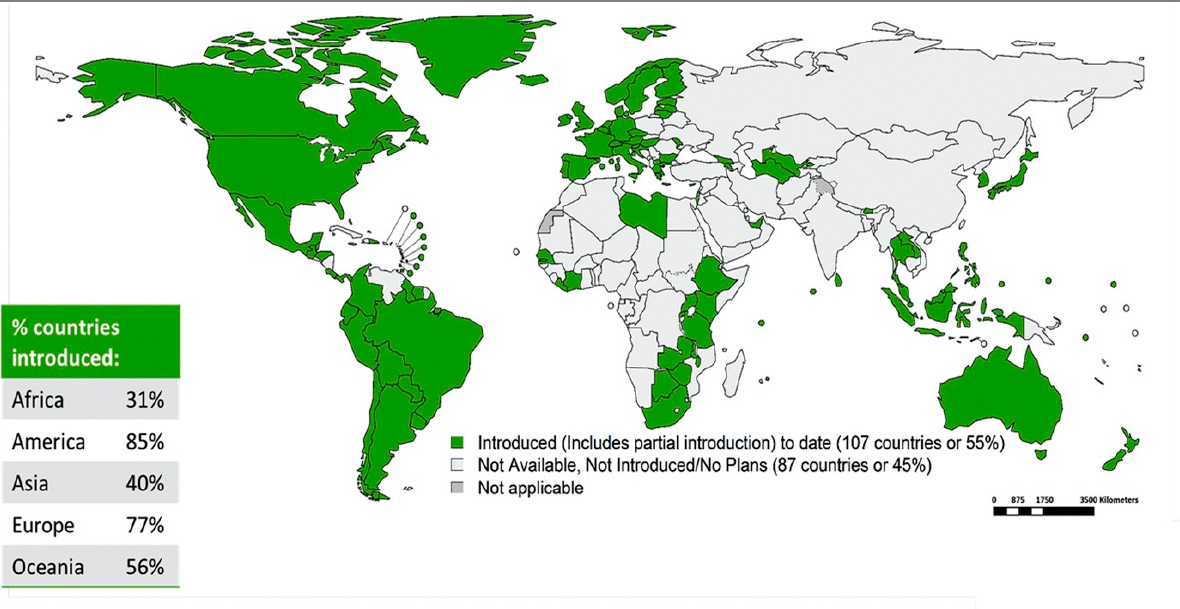
Figure 5. WHO member states with HPV vaccination in national immunisation schedule. (Repro- duced with permission from Bruni et al. [111]).